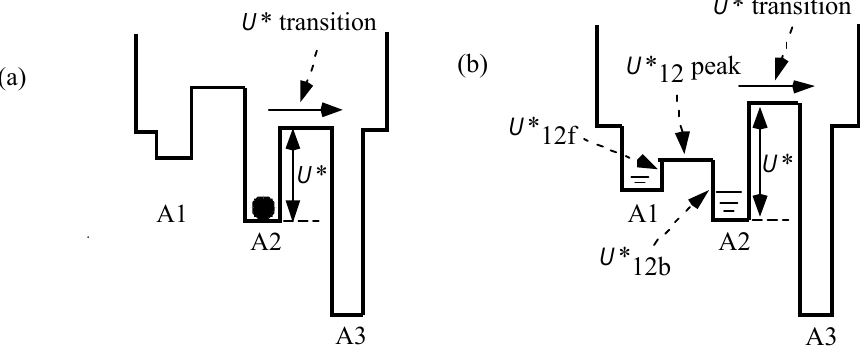
Figure 3. Potential of the force exerted on the myosin head in the MA complex. The 3 shape varies depending upon the tension T . (a) The case of T < T , where the force-velocity dev relation is Hill-type. The black circle indicates that the myosin head exists solely in well A2; (b) The case of T < T < T , where the existence probability of the myosin head is dev 0obs distributed in wells A1 and A2, causing deviation of the force-velocity relation from